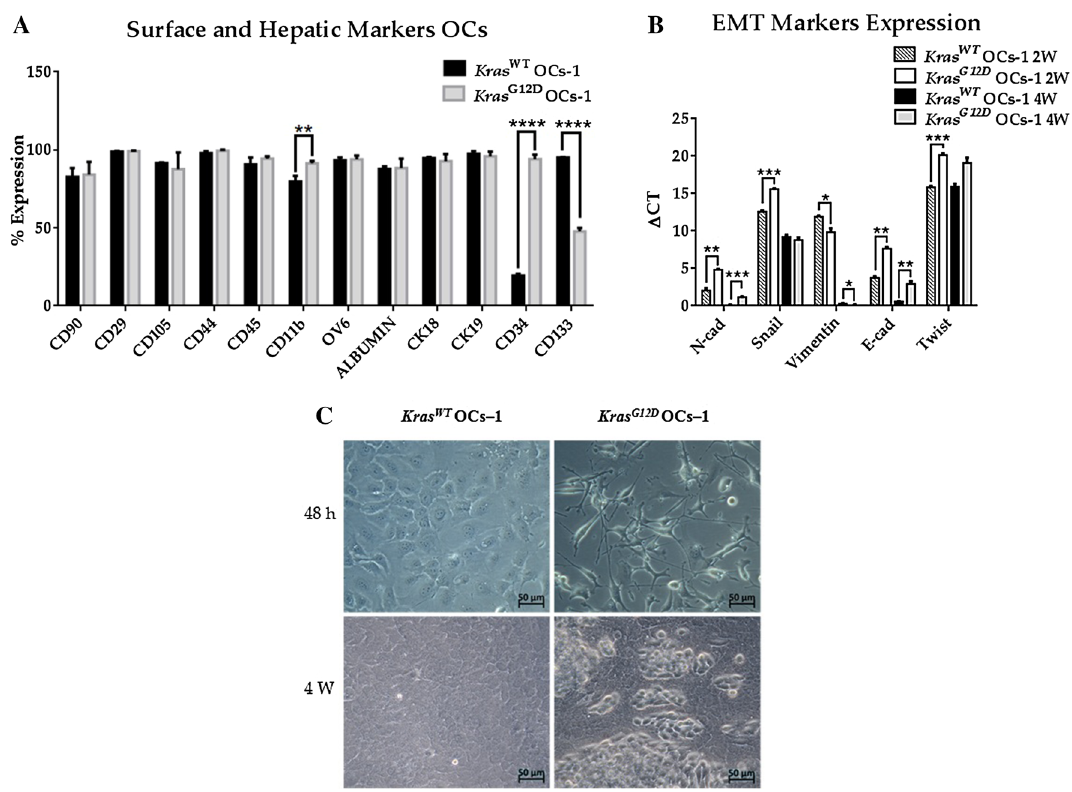
Figure 4. Changes observed in Kras G12D OCs-1 with respect to Kras WT OCs-1. Three replicates of Kras WT OCs-1 and Kras G12D OCs-1, Student’s t -test * p < 0.05, ** p < 0.01, *** p < 0.001, **** p < 0.0001, α = 0.05. ( A ) Mean of expression percentages and SD of hepatic and surface markers. ( B ) Variation of gene expression of mouse EMT markers (N-Cadherin, Snail, Vimentin, E-Cadherin and Twist) between 2 and 4 weeks of culture (2 W and 4 W respectively) analyzed by RT-qPCR normalized to Gapdh housekeeping gene. ( C ) Morphology changes observed at optical microscopy (O.M) at 48 h and 4 weeks of culture. Objective 40 ×.